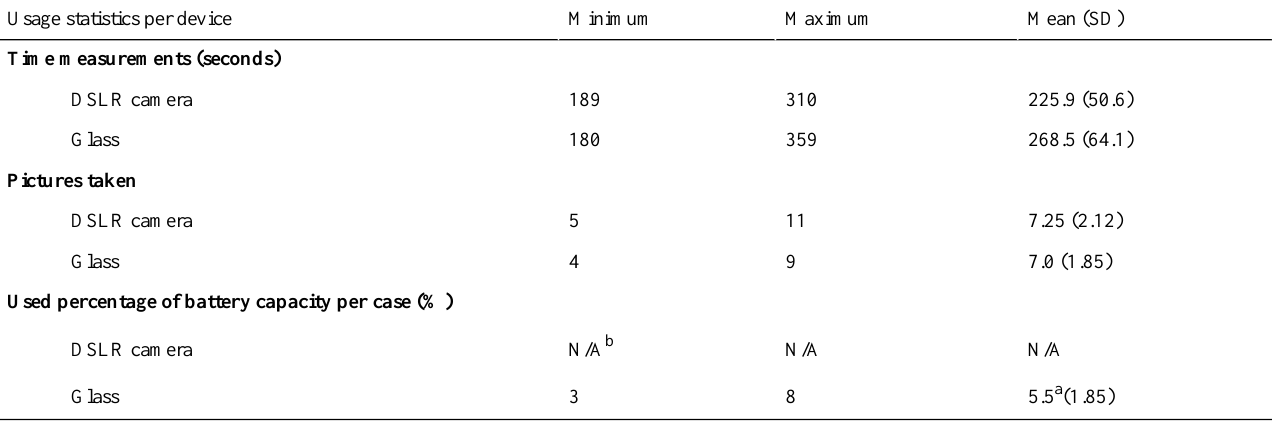
Table 1. Descriptive statistics of time measurements, number of pictures taken (per case), and loss of battery charge (per case) during postmortem examinations, stratified by device used to capture image: digital single-lens reflex (DSLR) camera or Google